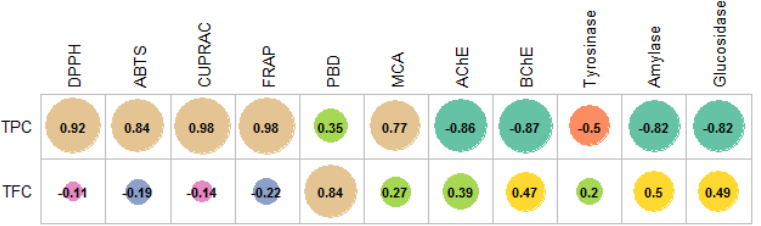
Figure 1. Pearson’s correlation between total bioactive compounds and antioxidant properties and enzyme inhibition effects ( p < 0.05).